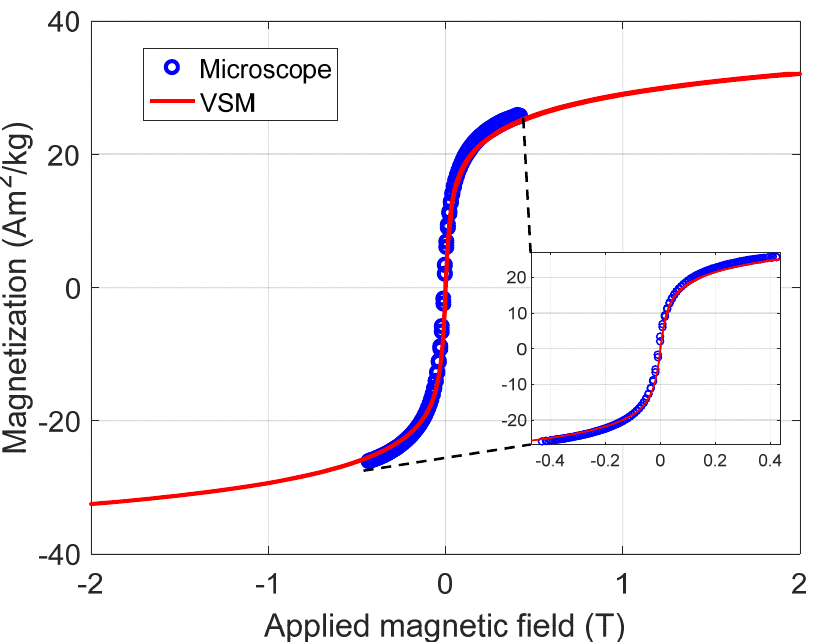
Figure 13. Graph representing the measurements of the sample NP0. The curve composed of blue circles is taken from data obtained from the measurement made in the magnetic microscope of PUC-Rio and the continuous curve in red color is the measurement made in the commercial magnetometer VSM.